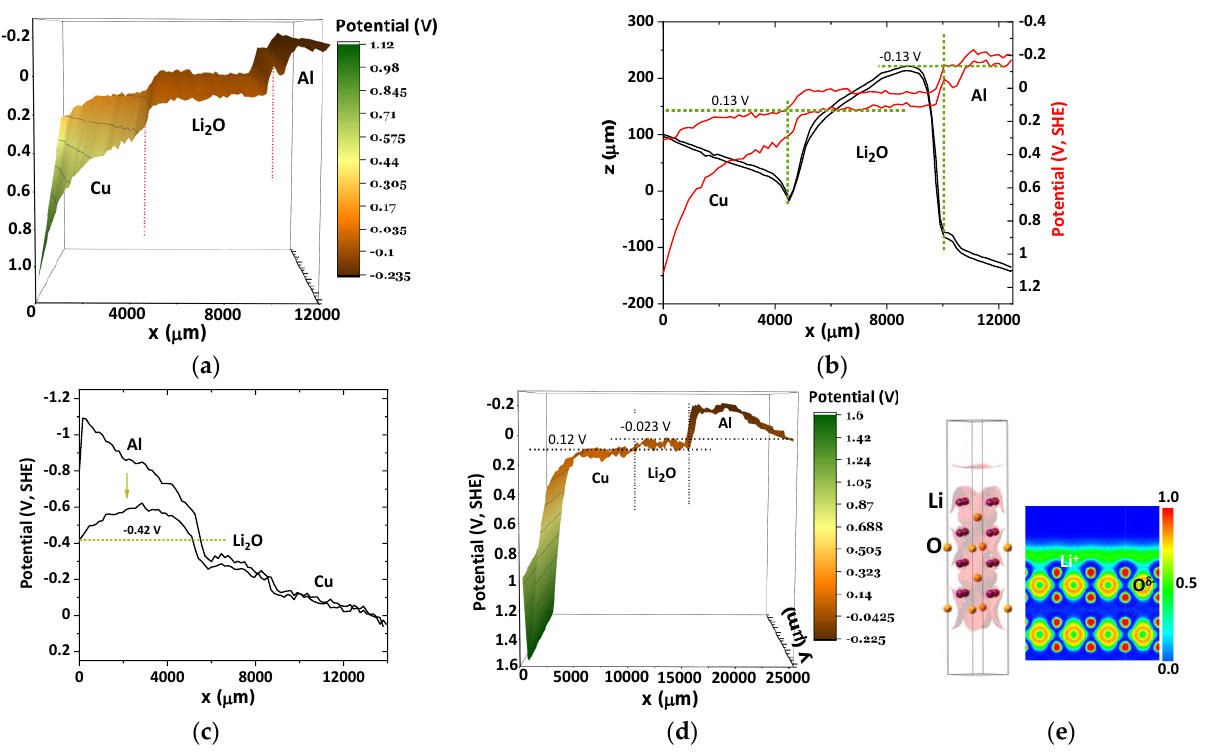
Figure 5. Topography and surface chemical potentials for an Al/Li 2 O/Cu cell show slightly different energies for the equalization of the surface chemical potentials of the heterojunctions Cu/Li 2 O and Li 2 O/Al. ( a , b ) SKP analysis showing p-type semiconductor band bending of Li 2 O when Cu was connected to the SKP; ( c ) p-type band bending observed in the surface potential of Li 2 O when Al is connected to the SKP showing small interfacial resistance at both interfaces; ( d ) SKP extended analysis not showing a pronounced p-type semiconductor band bending but rather a flat surface chemical potential of Cu/Li 2 O with a step toward the Al, reflecting internal interfacial resistance; ( e ) electron localization function (ELF): isosurface (3D) (ELF = 0.28) and slice (2D) showing delocalized electrons (ELF = 0.50) at the (001) surface of Li 2 O.